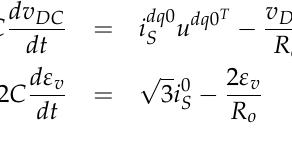
Figure 3. The TLSC SAPF equivalent simplified representation assuming a perfect control of i dq 0 s . Both the large- and small-signal models of the simplified TLSC SAPF are, respectively, given